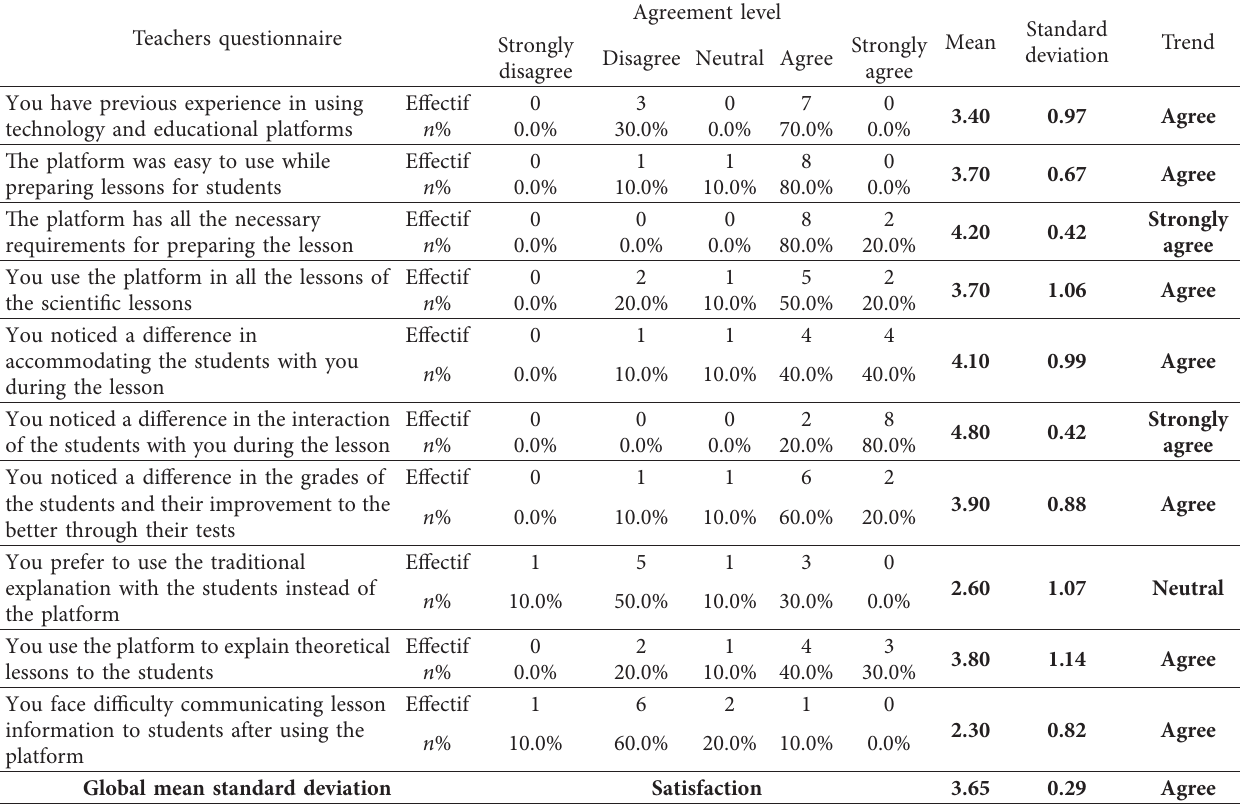
Table 7: Agreement level from the teachers’